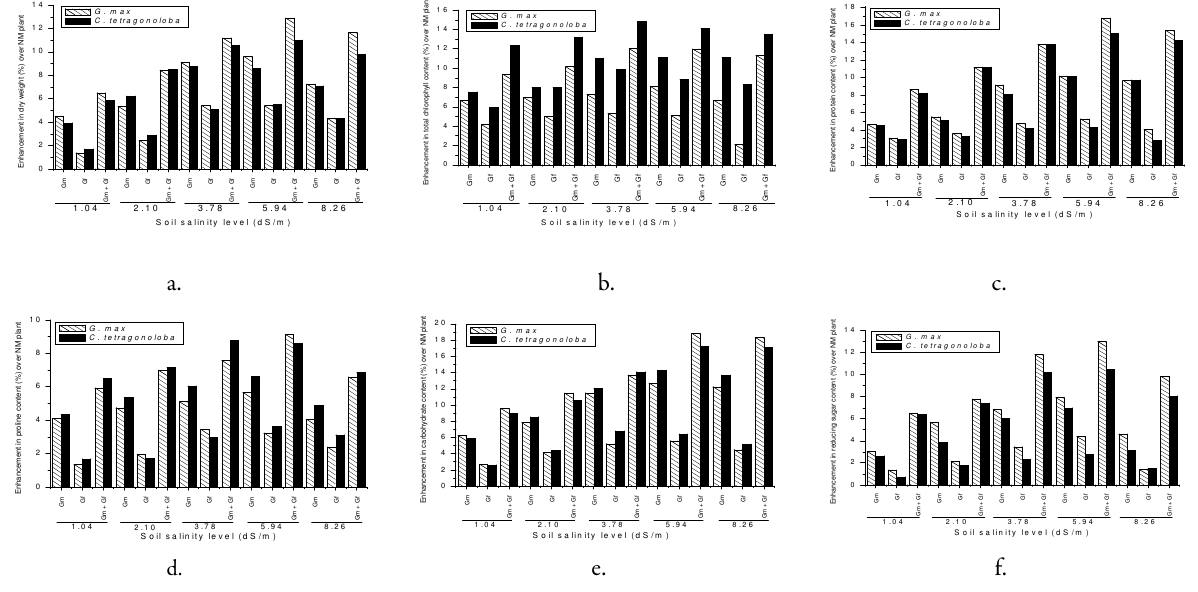
Fig. 1. Mycorrhizal response on enhancement of (a) dry weight yield, (b) total chlorophyll, (c) soluble protein, (d) free proline, (e) soluble carbohydrate, (f) reducing sugar content in individual and combined AM inoculated G. max and C. tetragonoloba over corresponding non-mycorrhizal plants exposed to control (1.04 dS/m) and increasing soil salinity gradient (2.10 to 8.26